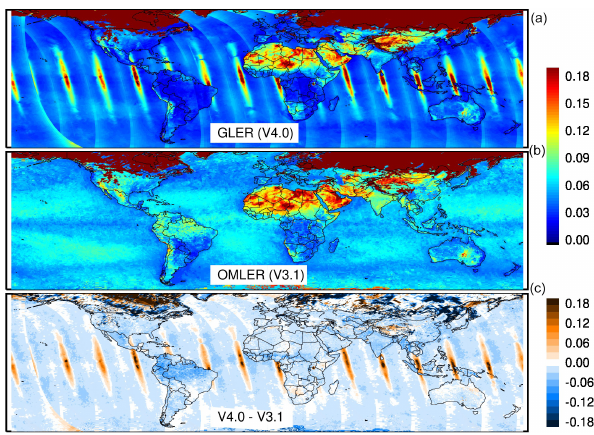
Figure 2. Surface reflectivity at 440nm (a) derived using MODIS BRDF data with OMI geometry (GLER) on 20 March 2005 com- pared with (b) OMI-based monthly LER climatology (OMLER) for the month of March (Kleipool et al., 2008). The bottom panel (c) shows the difference between MODIS-based and climatological surface reflectivity